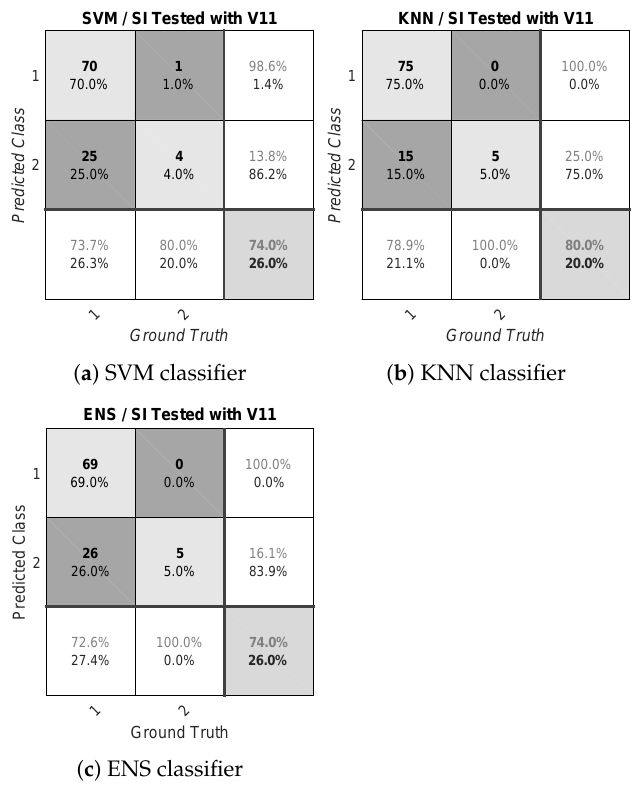
Figure A21. Confusion matrices for a subject-independent model tested with V11.